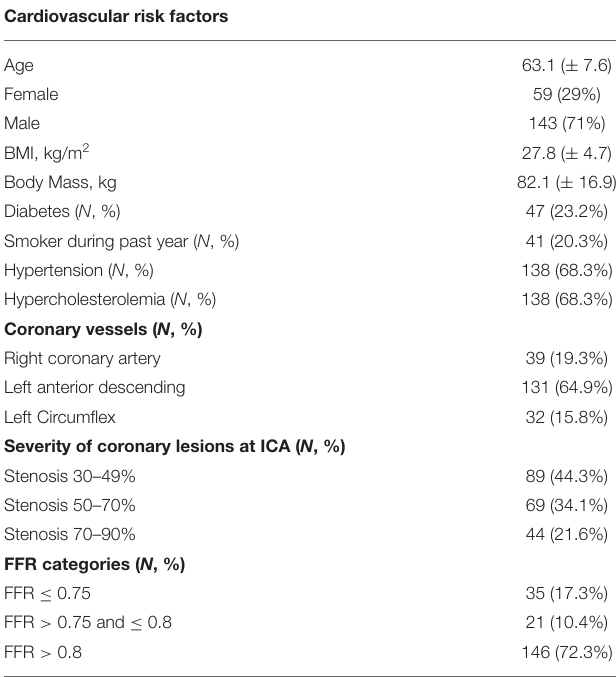
TABLE 3 | Patient demographics and vessel